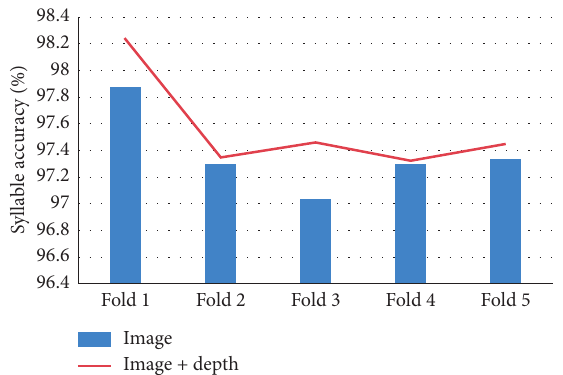
Figure 9: Tone recognition results of vowels and